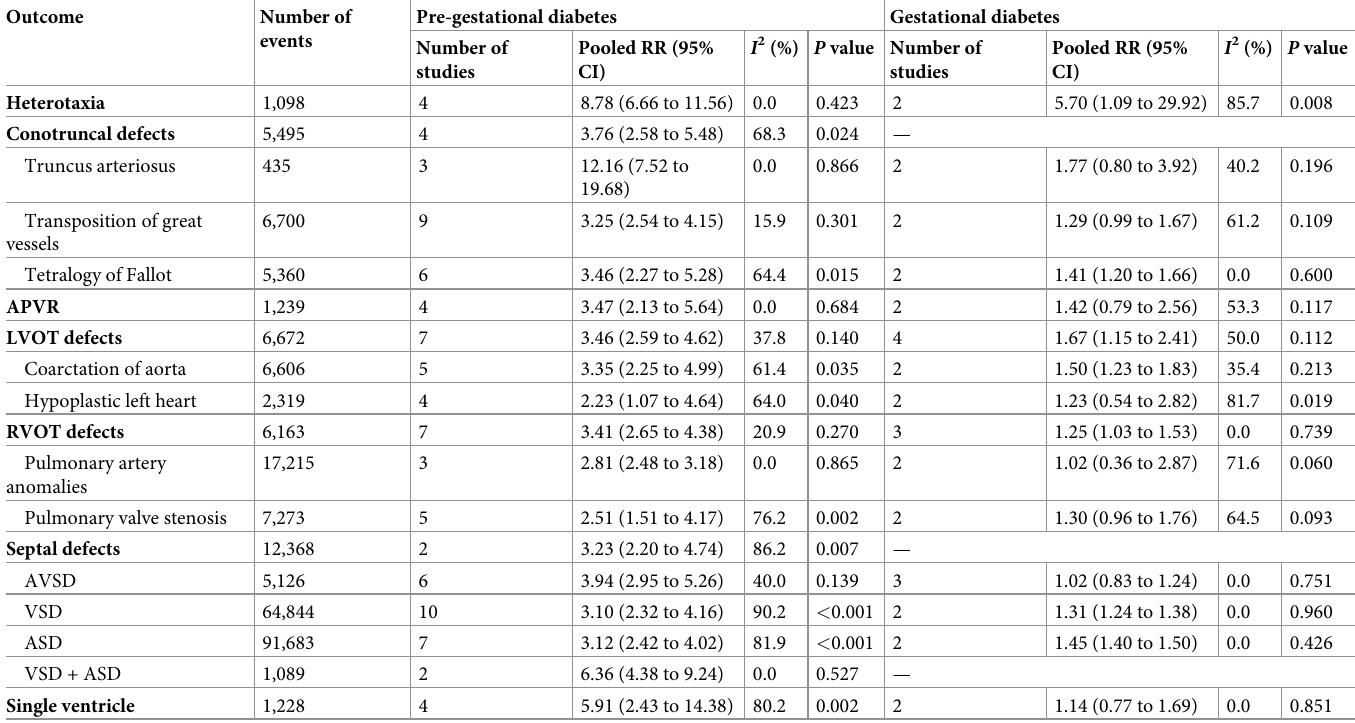
Table 2. Pooled RR and 95% confidence intervals for associations between maternal diabetes and any type of congenital heart defects .